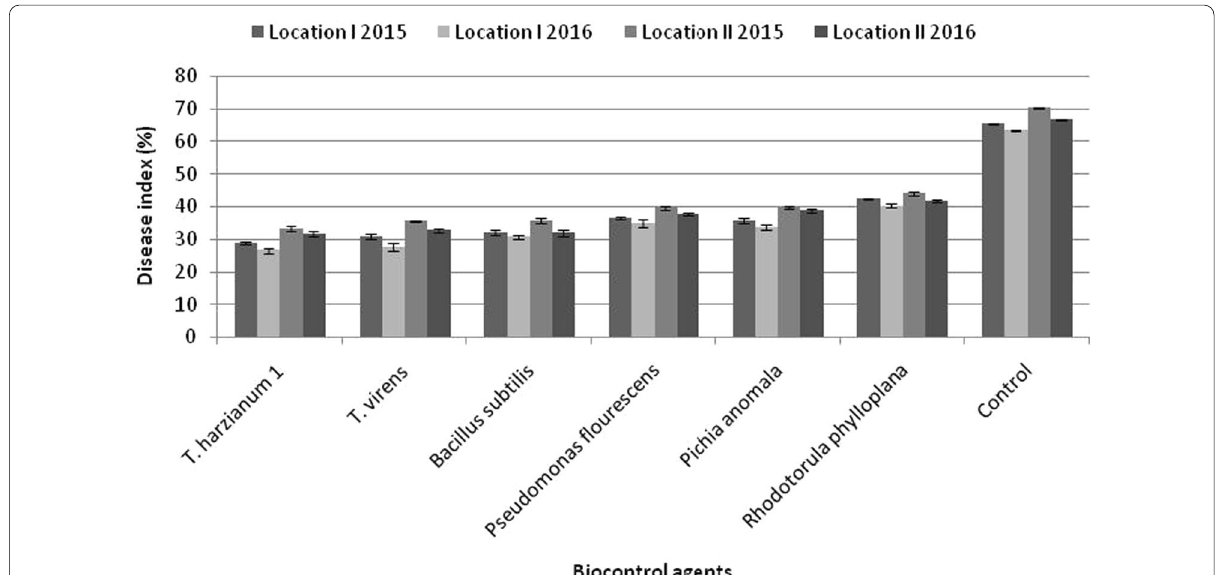
Fig. 6 Effect of bio-control agents on anthracnose development on mango fruits under field